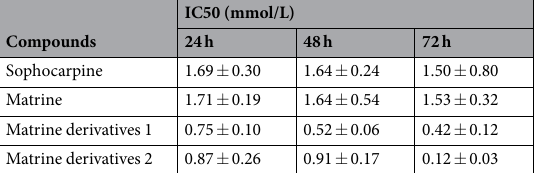
Table 4. IC50 of matrine derivatives 1 and 2 against Hela229